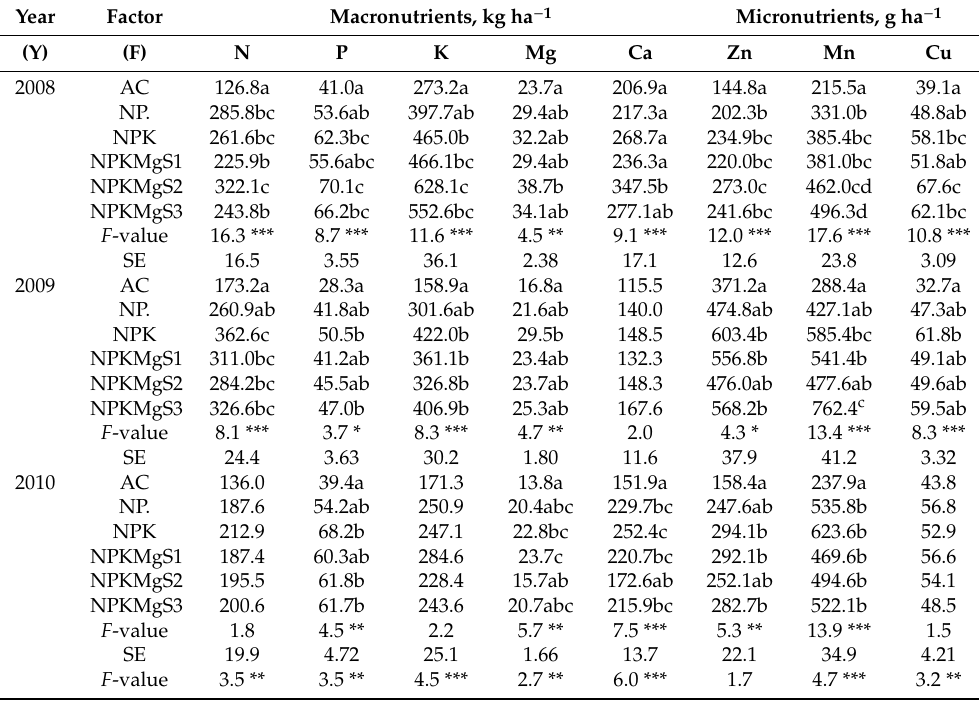
Table 6. Total nutrient content in oilseed rape at